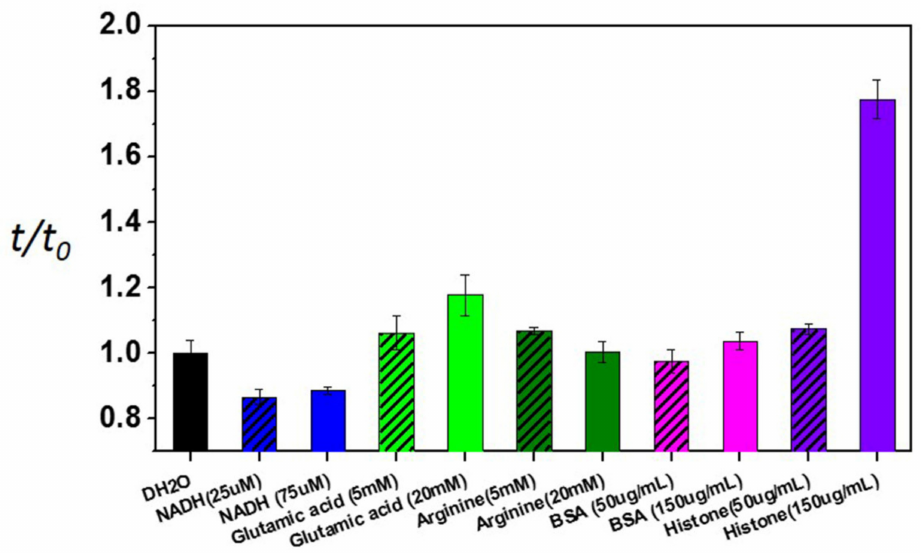
Figure 5. The e ff ects of di ff erent concentrations of coenzyme NADH, amino acids, proteins on the fluorescence lifetime of the CDs ( t 0 and t are the CD fluorescence lifetime in the DH 2 O and other solutions, respectively). Coenzyme NADH reduced the fluorescence lifetime of the CDs. Amino acid Arg and bovine serum albumin (BSA) did not a ff ect the fluorescence lifetime of the CDs. Glutamic acid slightly increased the fluorescence lifetime of the CDs, and 150 µ g mL − 1 histone greatly increased the fluorescence lifetime of the